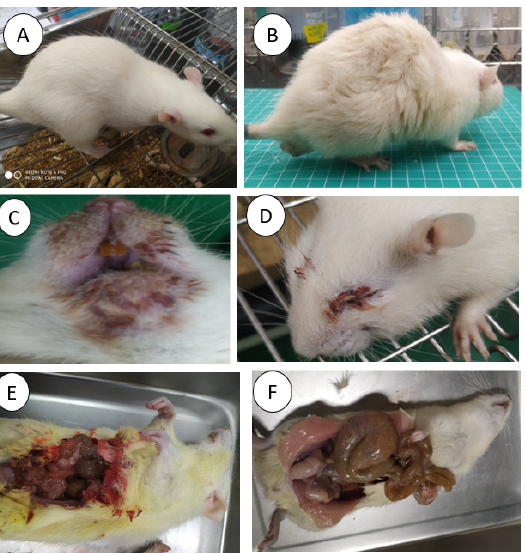
Figure 8. The clinical findings of rat eye, mouth, body shape, and organs on the sixth day and tenth day of experiment. ( A ) The appearance of a rat in the5-FU+100 group like rats in the WT group; ( B ) the appearance (arched back) of a rat in the 5-FU group; ( C ) the perioral edema of a rat found in the 5-FU group; ( D ) the periocular tissue changes including scarring and periorbital edema in a rat of the 5-FU group; ( E ) the colon size and intestinal organs in a rat of the WT group; ( F ) the abnormal enlargement of colon (megacolon), kidney rupture, and the dark lung found in a dead rat in the 5-FU+G group.